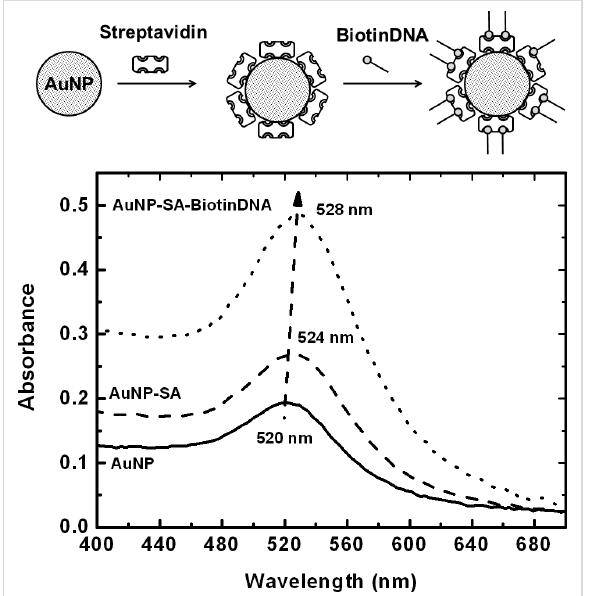
Figure 2: Absorbance spectra of bare AuNPs and SA coated nanopar- ticles before (AuNP-SA) and after (AuNP-SA-BiotinDNA) the adsorp- tion of biotinylated oligonucleotides. The change of the intensity of the peaks reflects the different concentration of colloidal dispersions after each functionalization